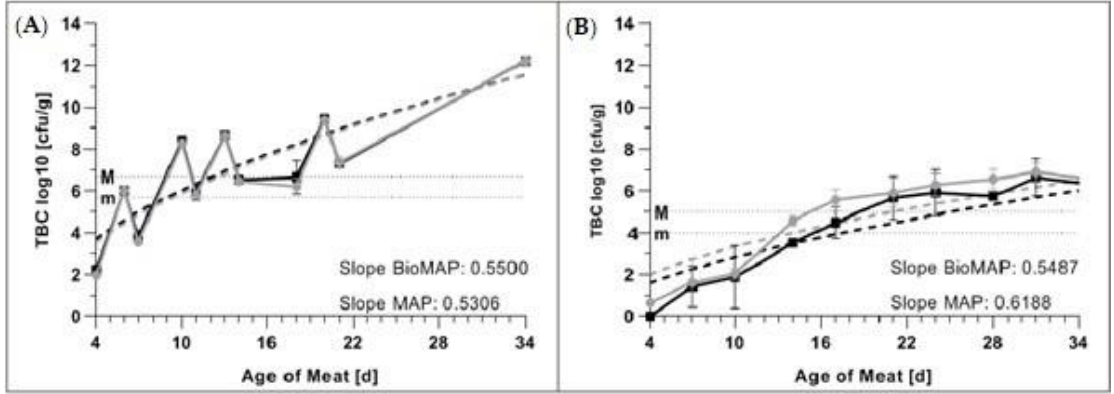
Figure 5. Average TBCs (±S.D.) in BioMAP and MAP in ( A ) ground pork (GM) and ( B ) Figure 5. Average TBCs ( ± S.D.) in Figure A2. Average TBCs (±S.D.) in BioMAP and MAP in ( A ) ground pork (GM) and BioMAP and Figure A2. Average TBCs (±S.D.) in BioMAP and MAP in ( A ) ground pork (GM) and MAP in ( A ) ground pork (GM) and pork loin (PL) over a meat age of 34 days. Microbiological limits “m” and “M” as per European Union ( B ) pork loin (PL) over a meat age of 34 and 52 days, respectively. Microbiological limits “m” and ( B ) pork loin (PL) over a meat age of 34 and 52 days, respectively. Microbiological limits “m” and ( B ) pork loin (PL) over a meat age of 34 days. Microbiological limits “m” and “M” as per European legislation are indicated for both meat matrices. The fitted curves are indicated by dotted lines for GM “M” as per European Union legislation are indicated for both meat matrices. The fitted curves are “M” as per European Union legislation are indicated for both meat matrices. The fitted curves are Union legislation are indicated for both meat matrices. The fitted curves are indicated by dotted lines and PL in BioMAP and MAP, respectively, with slope values included in the graphs . indicated by dotted lines for GM and PL in BioMAP and MAP, respectively, with slope values indicated by dotted lines for GM and PL in BioMAP and MAP, respectively, with slope values for GM and PL in BioMAP and MAP, respectively, with slope values included in the included in the graphs. included in the graphs.